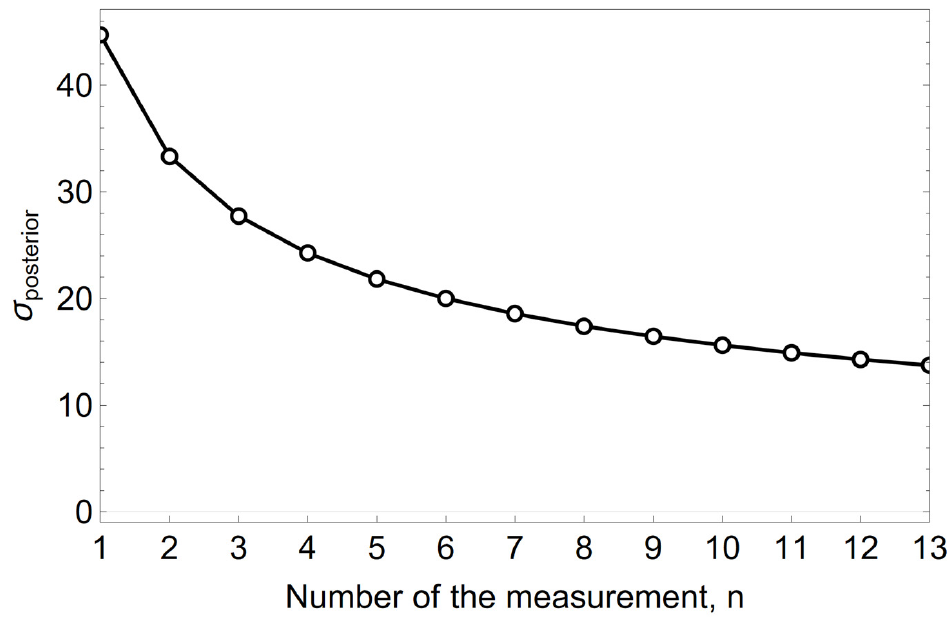
Figure 6. The variation of the standard deviation σ µm heat − 1 of the a posteriori distribution of the unit refractory wear rate in the spout zone.